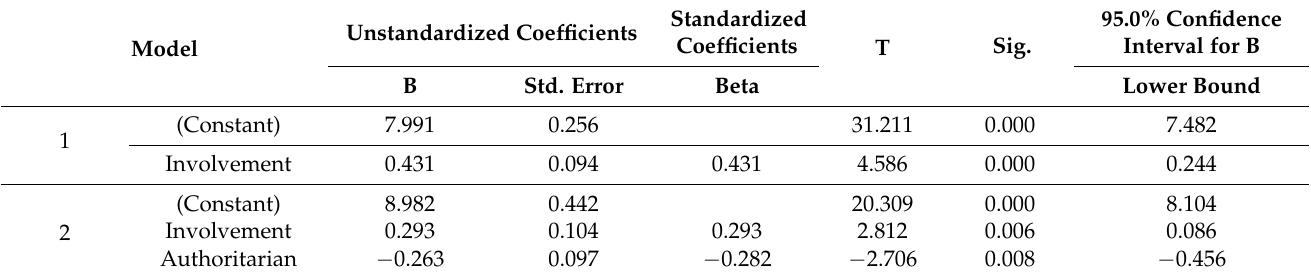
Table 2. Correlation between involvement and authoritarian style and school achievement.